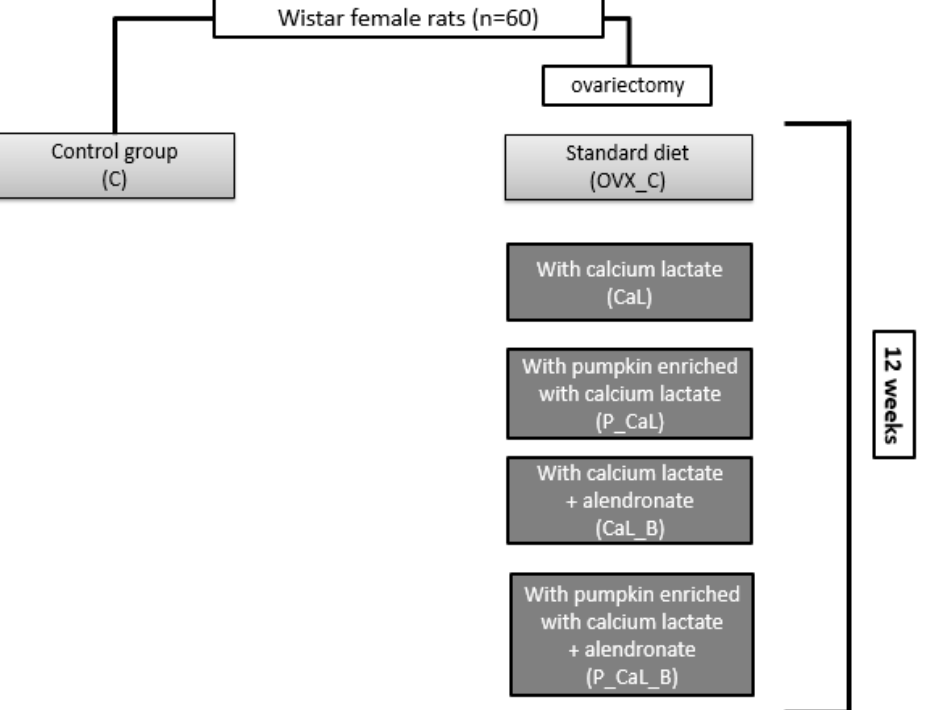
Figure 1. The scheme of the study. Groups shown in light-gray boxes were given the standard diet; the basic diet of the groups shown in the dark-gray boxes was a diet without calcium.